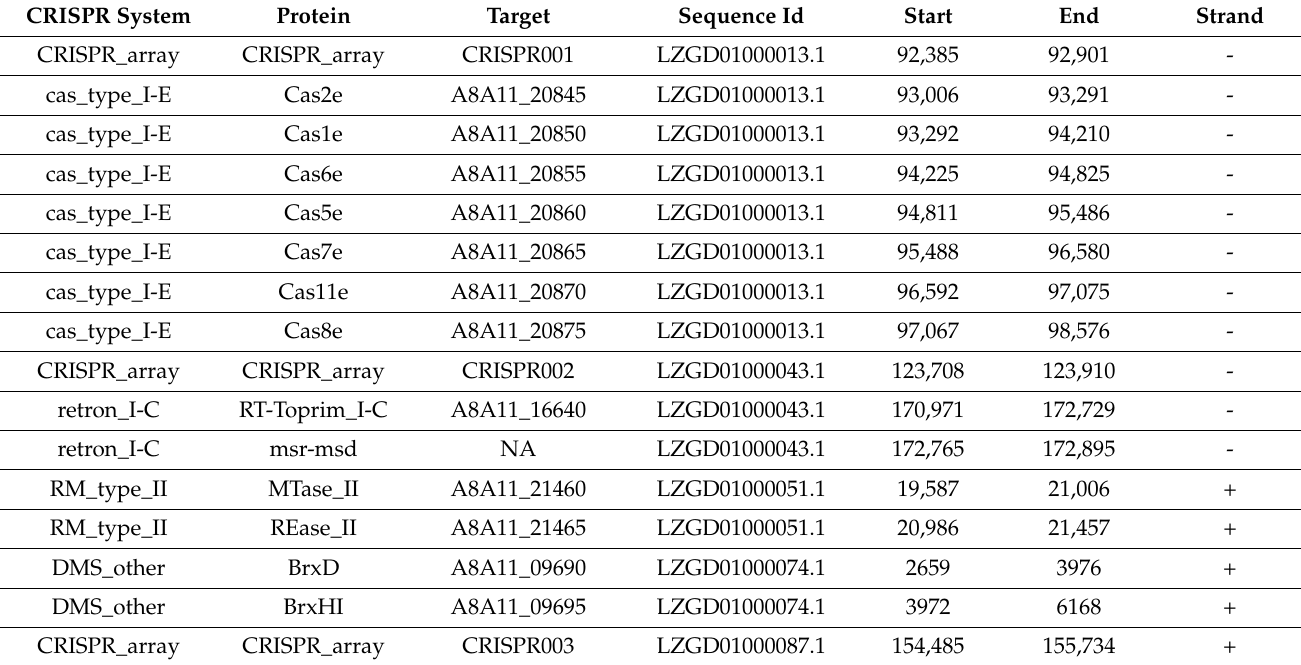
Table 2. Probable CRISPR systems in E.coli ECU32 using PADLOC